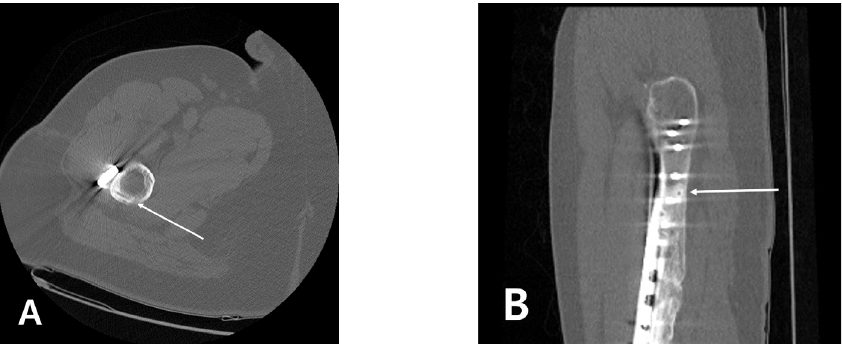
Figure 5. Computed tomography (CT) scan taken 4 years after the first operation. ( A ) The axial image showed linear trace along the cortex; ( B ) The sagittal image also revealed an unhealed pinhole in the proximal femur (white arrow).